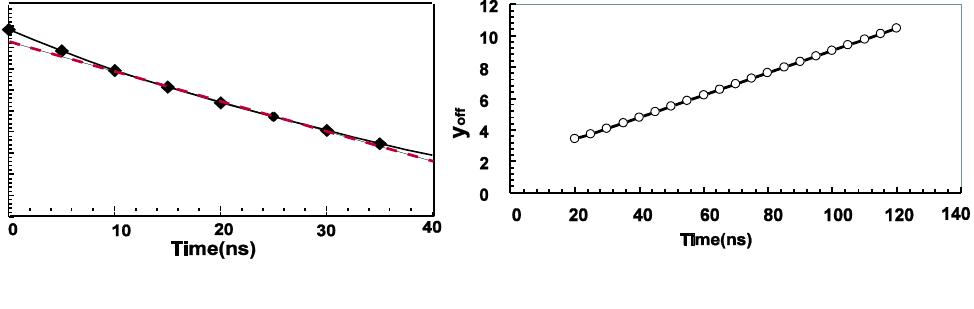
Figure 16. Simulated